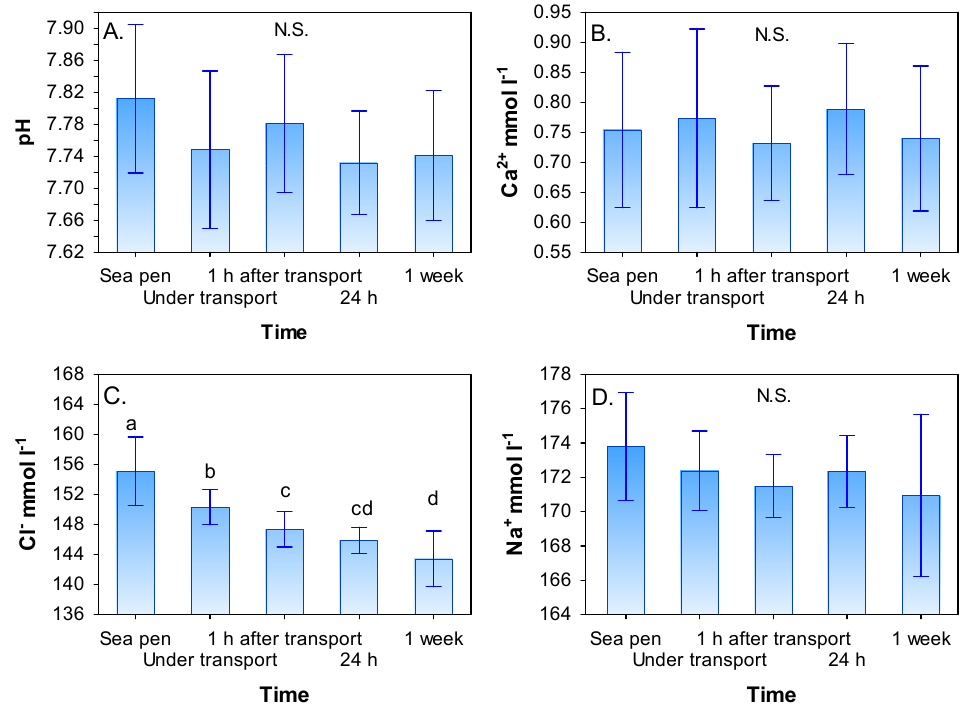
Figure 2. Changes in blood plasma pH ( A ), Ca 2+ ( B ), Cl − ( C ) and Na + ( D ) for lumpfish before and under transport, 1 h, 24 h and one week after transport. Values are given as mean (SD). N = 20–30 for all groups. Different letters denote significant difference (Student–Newman–Keuls (SNK) test, p < 0.05) between treatments. N.S. = not significant.